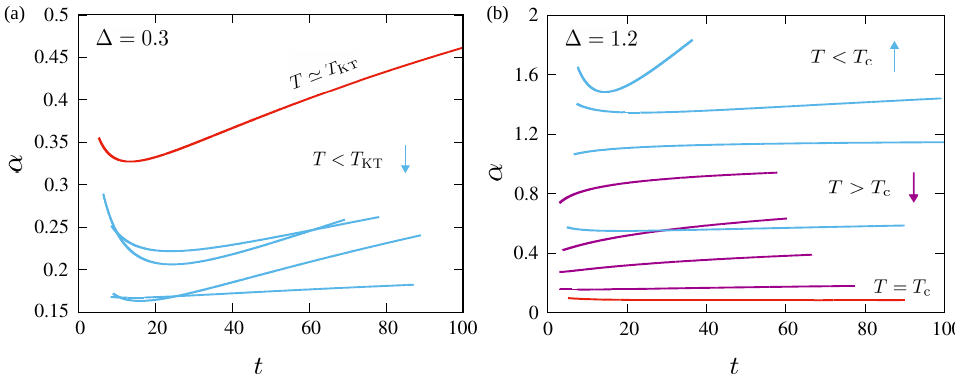
Figure 15: Spin-spin auto-correlation function: (a) Exponential decay of ˜ C ( ∼ e − t /τ ) for easy-plane and easy-axis anisotropies at temperature above the transi- tions. For ∆ = 0.3, the relaxation time ( τ ) decreases with increasing temperature, whereas it increases for ∆ = 1.2 (see Figs.4(a),(b) in the main text). (b) Power law ( t ) ( ∼ t − α ) at long times for ∆ = 1.2 across the Ising transition. α behaviour of ˜ C zz is found by calculating the slope of the linear regime ( t (cid:166) 5) in the log-log plot, e.g. shown by the dashed line for T = 0.78. Similar plot for the easy-plane case is shown in Fig.6(a) of the main text.